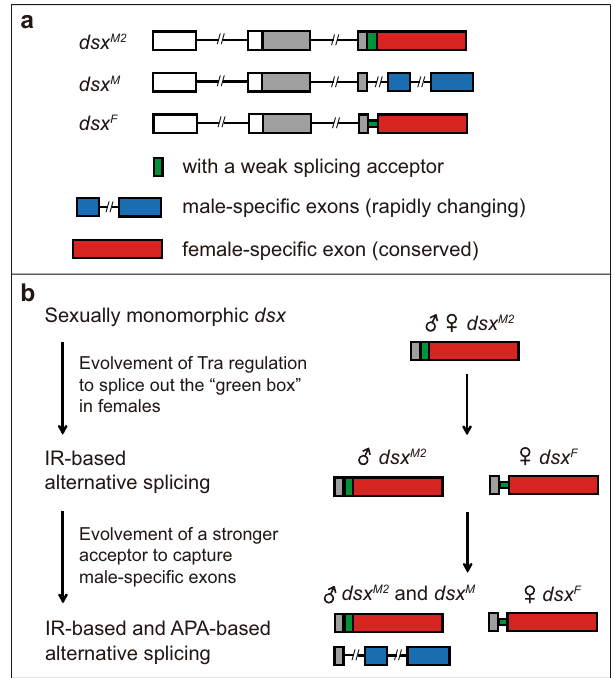
Fig. 5 An evolutionary pathway of dsx alternative splicing underlying sexual development. a Structures of the modern day dsx transcripts, dsx M2 , dsx M , and dsx F in D. melanogaster . b A proposed evolutionary pathway from sexually monomorphic dsx M2 to sex-speci fi c dsx transcripts sequentially via the IR-based and APA-based